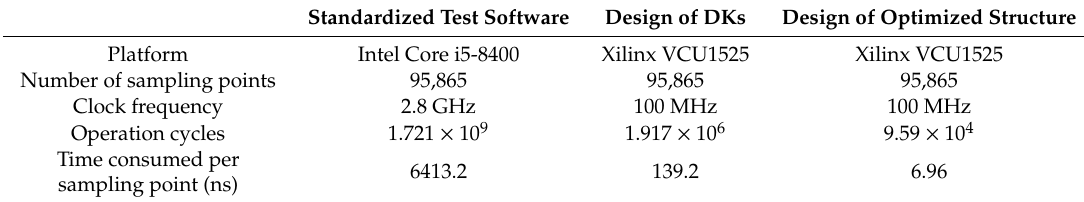
Table 4. Comparison of phase rotation acceleration system and software